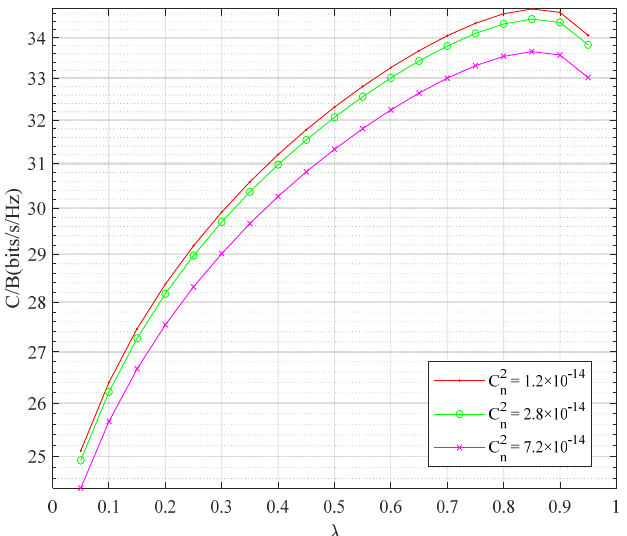
Figure 8. System average channel capacity under different turbulence intensities and constellation priority parameters.